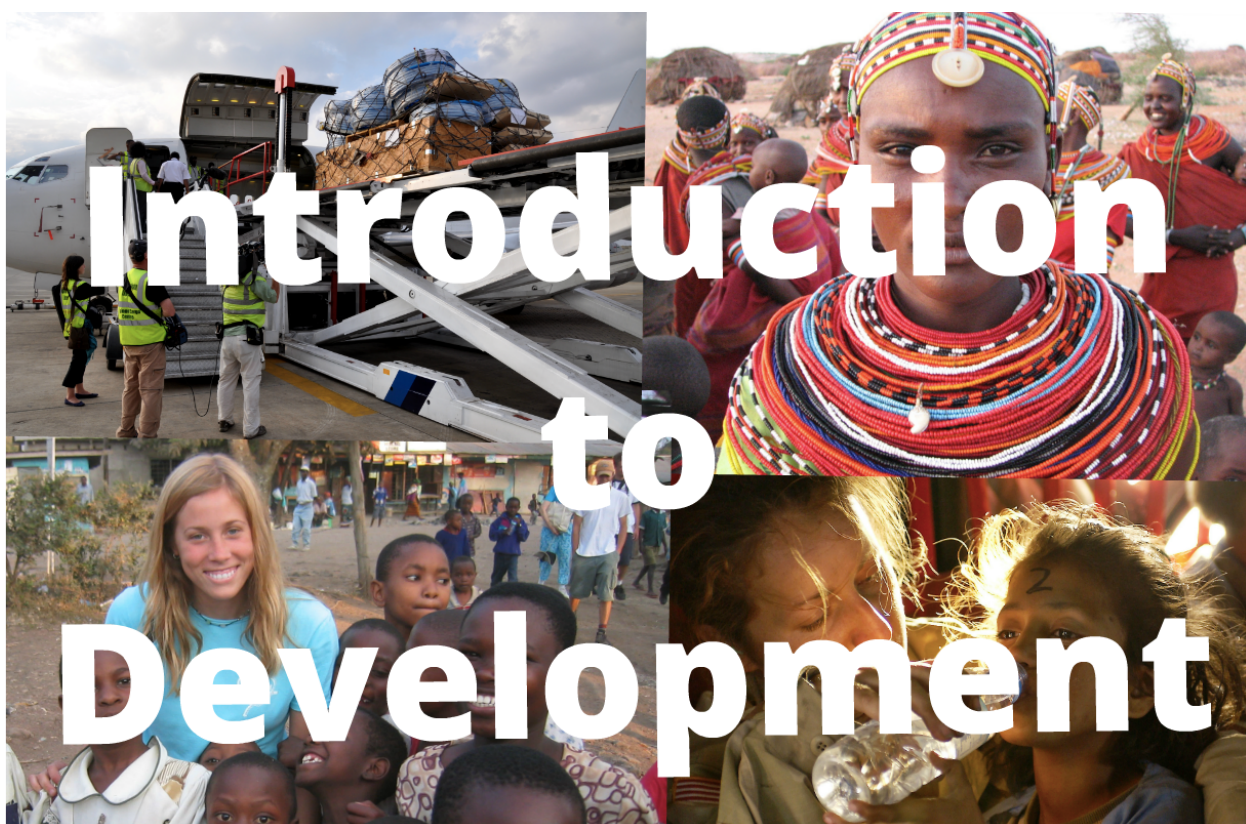
FIGURE 1 : OPENING SLIDE WITH FAMILIAR TROPES FROM DEVELOPMENT AGENCY “POVERTY